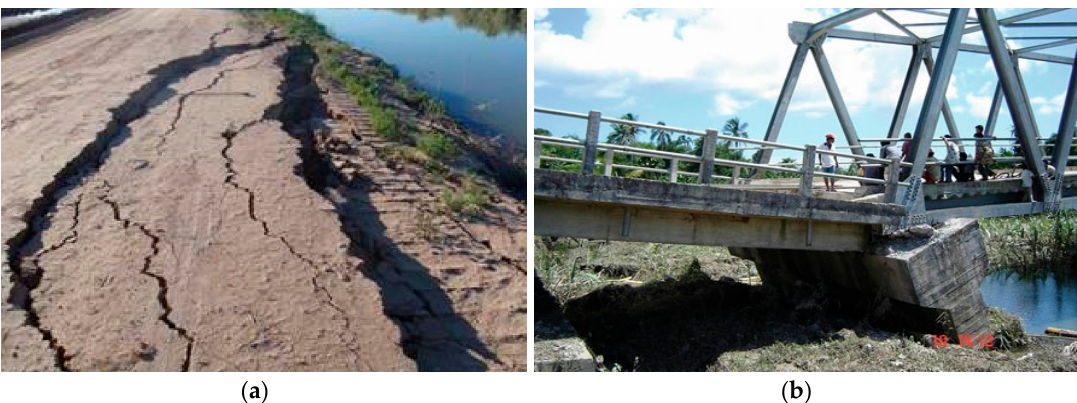
Figure 3. Historical cases of lateral spread: ( a ) lateral spread ground failure near the west levee of Westside Main Canal in the 2010 Sierra El Mayor Mw7.1 earthquake (photo taken by John Tinsley on 4/7/10, Mccrick et al. (2011) [14]); ( b ) lateral spread affecting the piers of the Muzoi Bridge in the 2005 Nias Island Mw 8.6 earthquake (modified from Aydan et al. (2005) [15]).